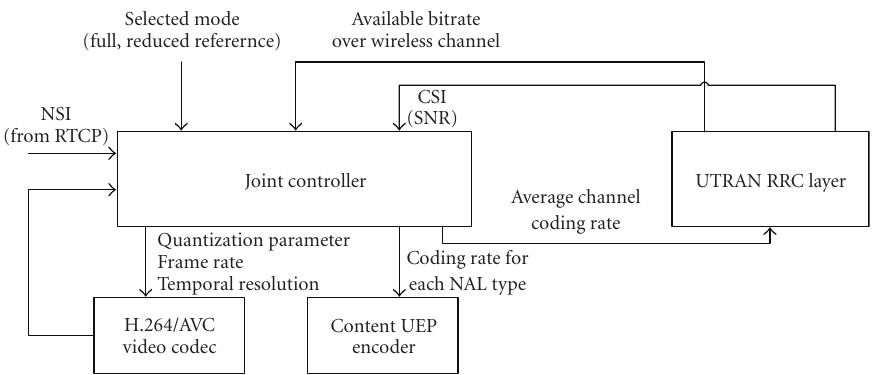
Figure 2: Joint controller inputs and outputs.